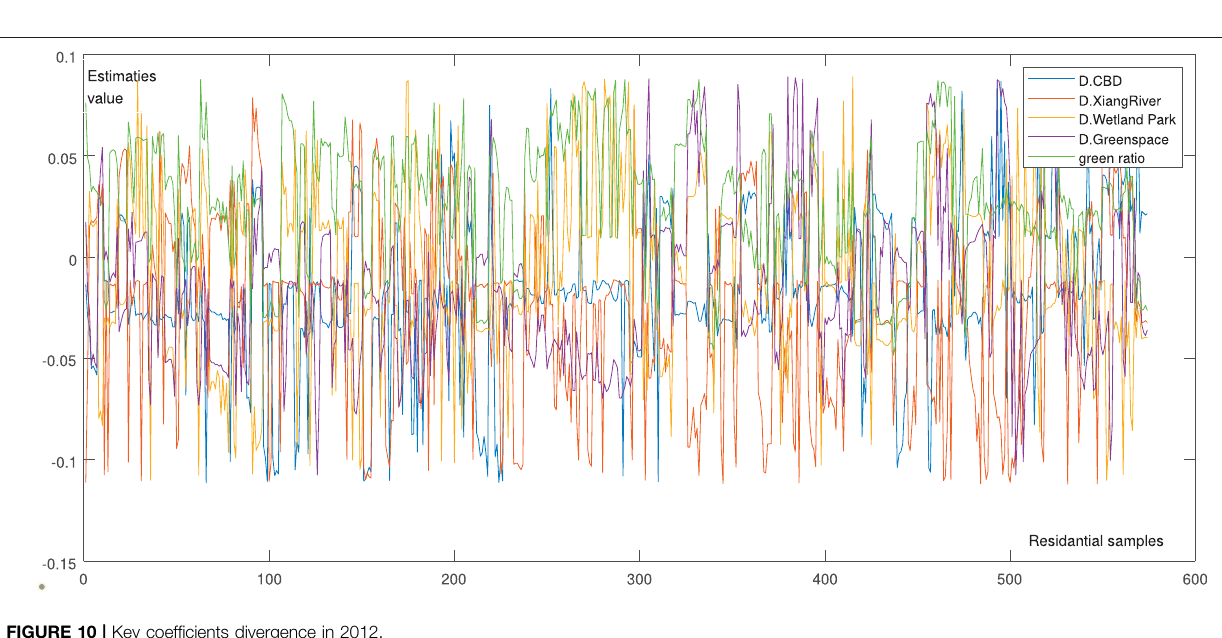
FIGURE 10 | Key coef fi cients divergence in